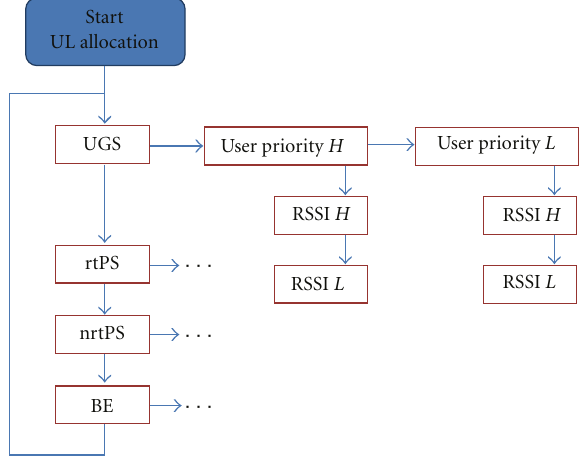
Figure 8: Enhanced Round Robin algorithm. Table 1: Simulation